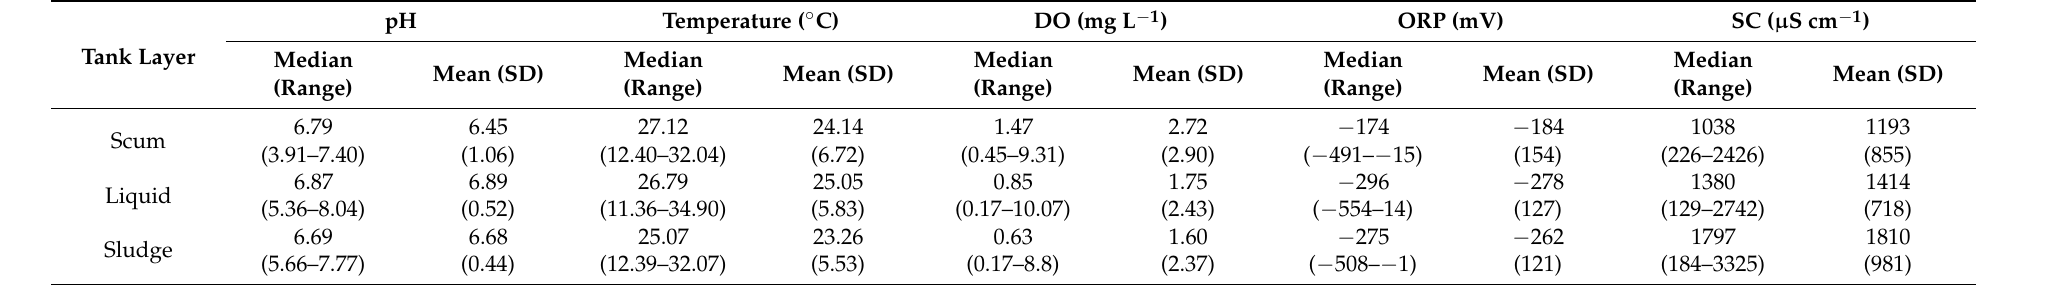
Table 1. Mean ± standard deviation of layer thickness and environmental readings for domestic septage. DO = dissolved oxygen; ORP = oxidation-reduction potential; SC = specific